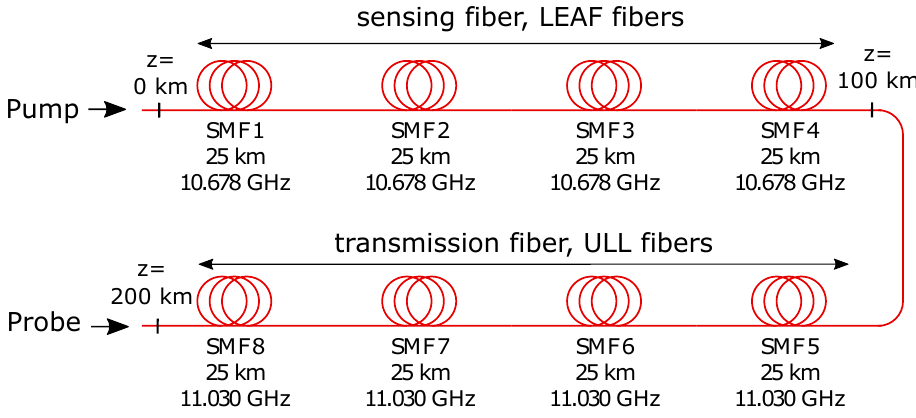
Figure 2. Configuration of the fiber loop (sensing and transmission